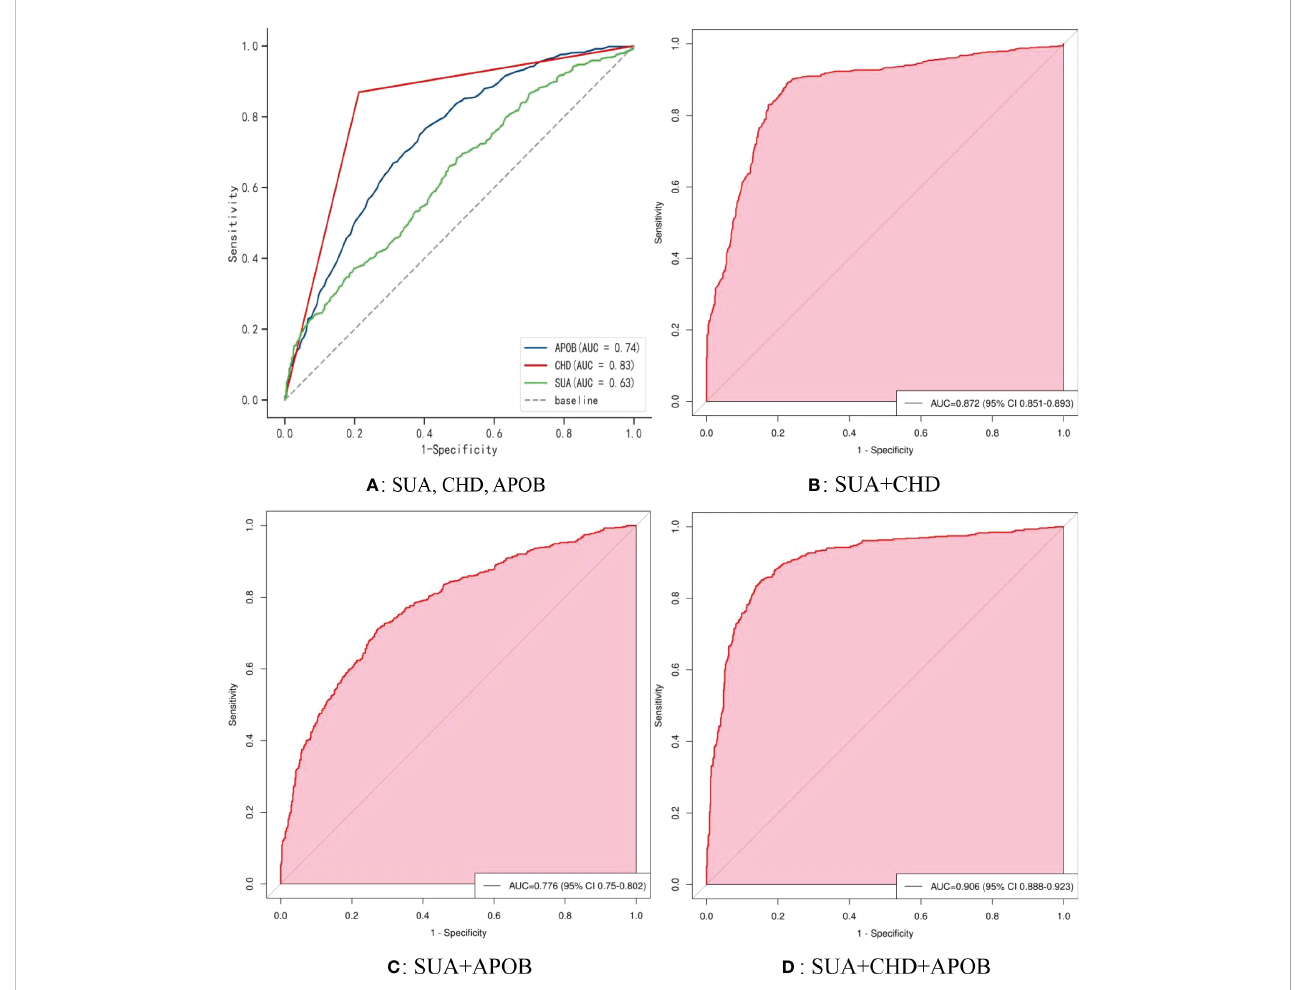
FIGURE 5 The receiver operating characteristic (ROC) curve model of SUA for diagnosing AF in the normoglycemic pattern. (A) Performance of SUA, CHD, and APOB for predicting AF. (B) Performance of SUA combined with CHD for predicting AF. (C) Performance of SUA combined with APOB for predicting AF. (D) Performance of SUA combined with CHD and APOB for predicting AF. SUA, serum uric acid; CHD, coronary heart disease; APOB, apolipoprotein